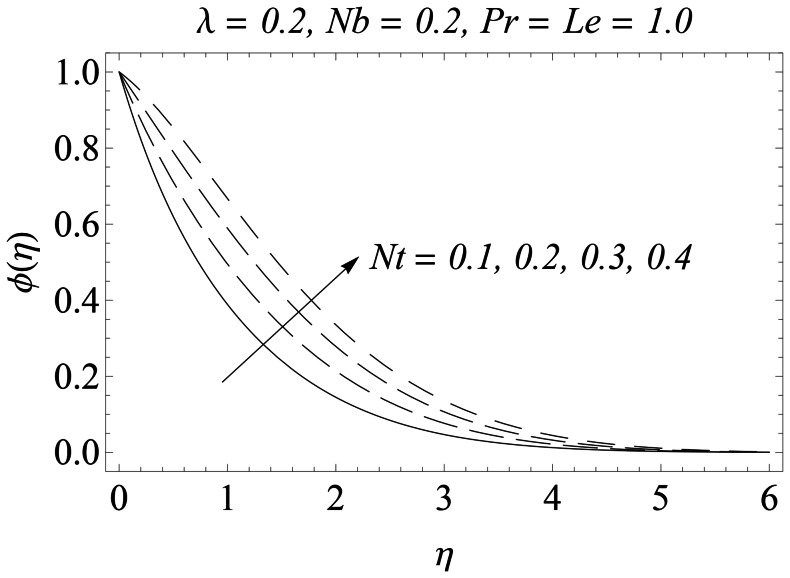
Influence of Nt on .